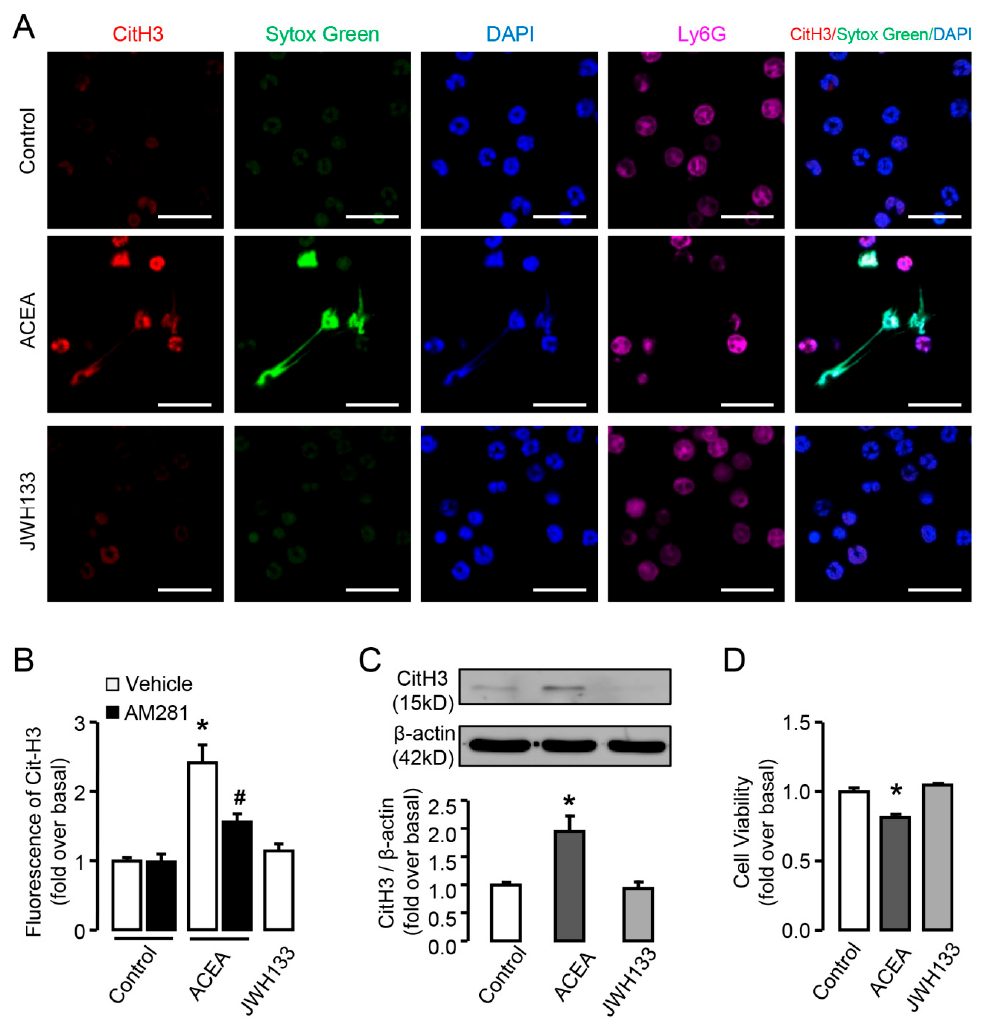
Figure 4. CB1 but not CB2 is involved in CitH3 expression and NETosis in vitro. ( A ) Representative confocal images of CitH3 (red) and Ly6G (violet) immunofluorescent staining and NETosis in ACEA or JWH133-treated neutrophils. The nuclei were stained with SYTOX ® Green (green) and DAPI (blue). Scale bars, 20 µm. ( B ) Quantification of CitH3 and NETosis in ACEA or JWH133-treated neutrophils. ( C ) CitH3 protein level in ACEA or JWH133-stimulated neutrophils was examined by Western blot. ( D ) Cell viability of neutrophils treated by ACEA or JWH-133 by CCK-8 assay. Data are presented as the mean ± SEM. N = 4 per group. * P < 0.05 vs. control. # P < 0.05 vs. ACEA-treated alone.